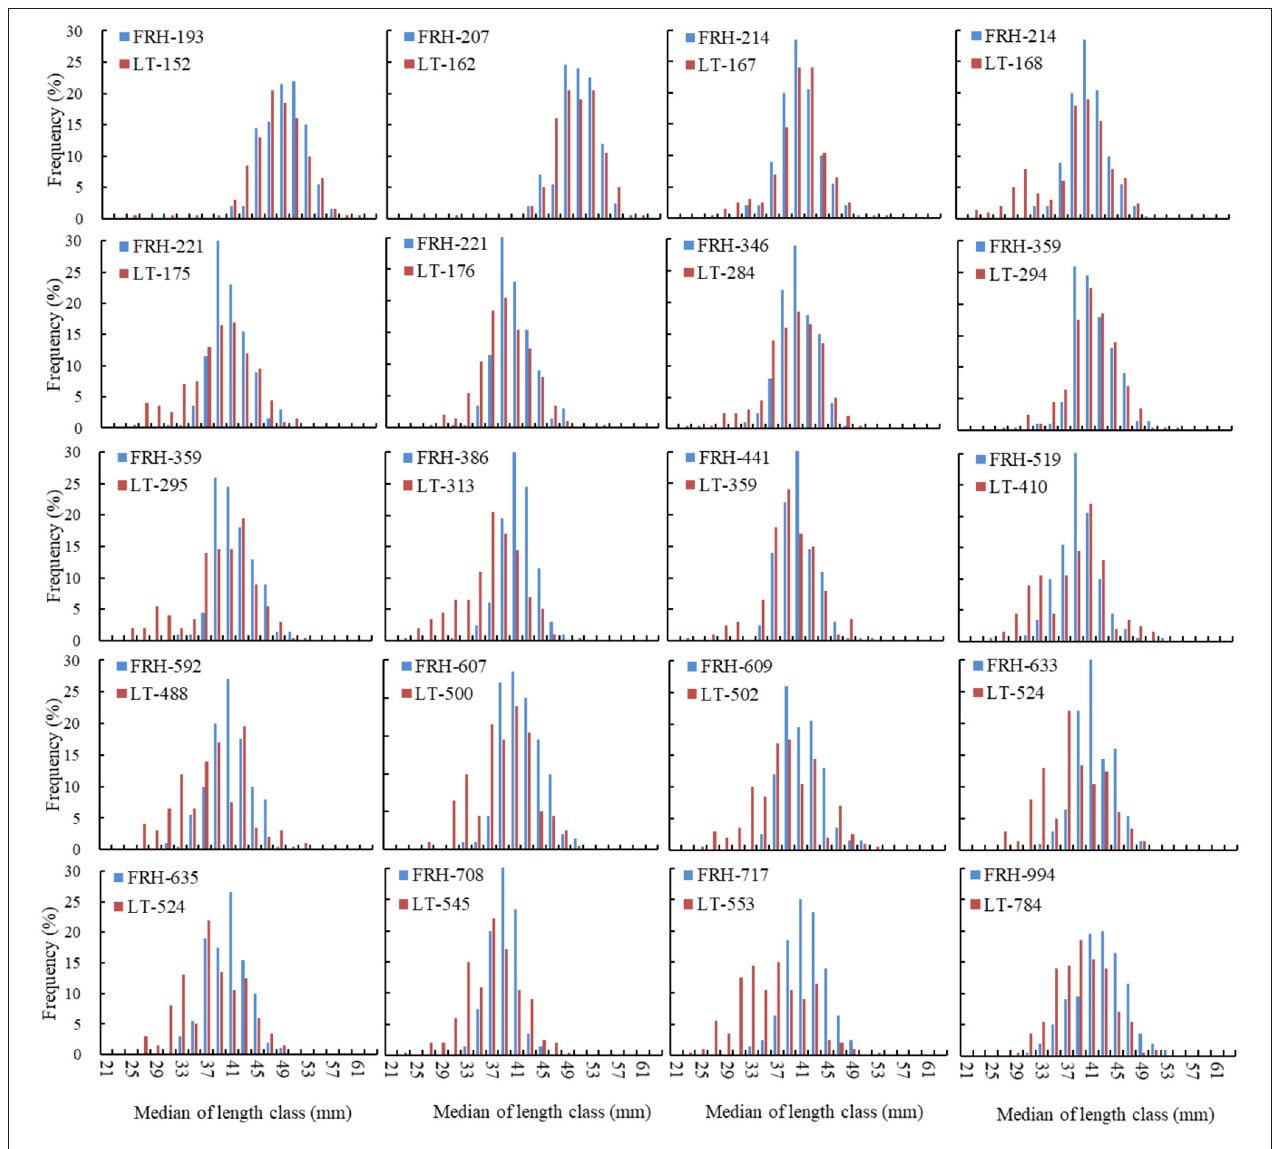
FIGURE 2 | Inter-trawl differences of krill length frequencies in the catches of matched